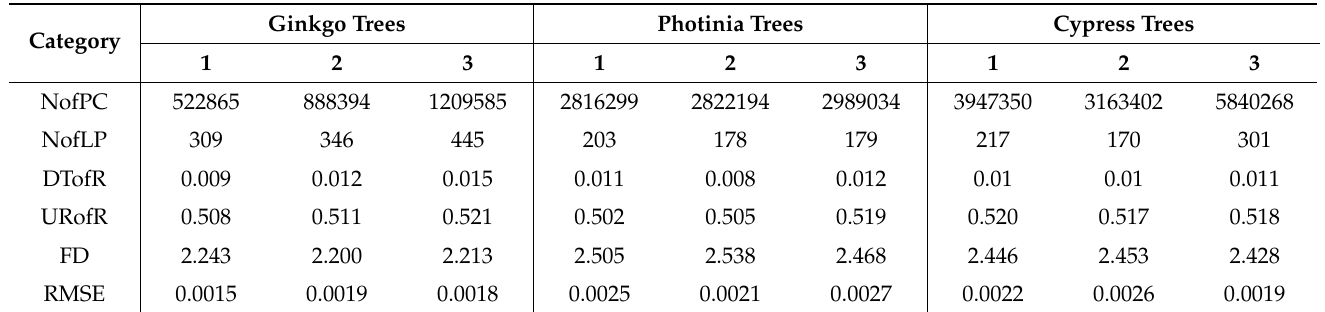
Table 5. Fractal dimension calculation results of ginkgo, photinia and cypress